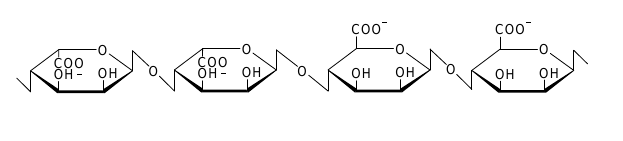
Figure 6. The structure of an alginate and its modification.